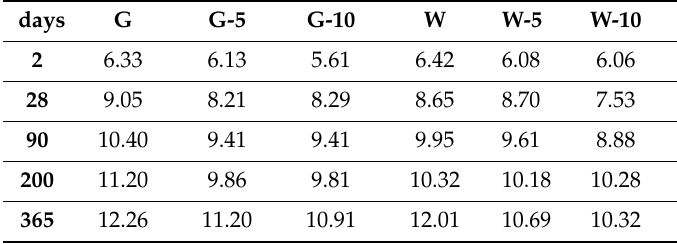
Table 1. Results of flexural strength tests